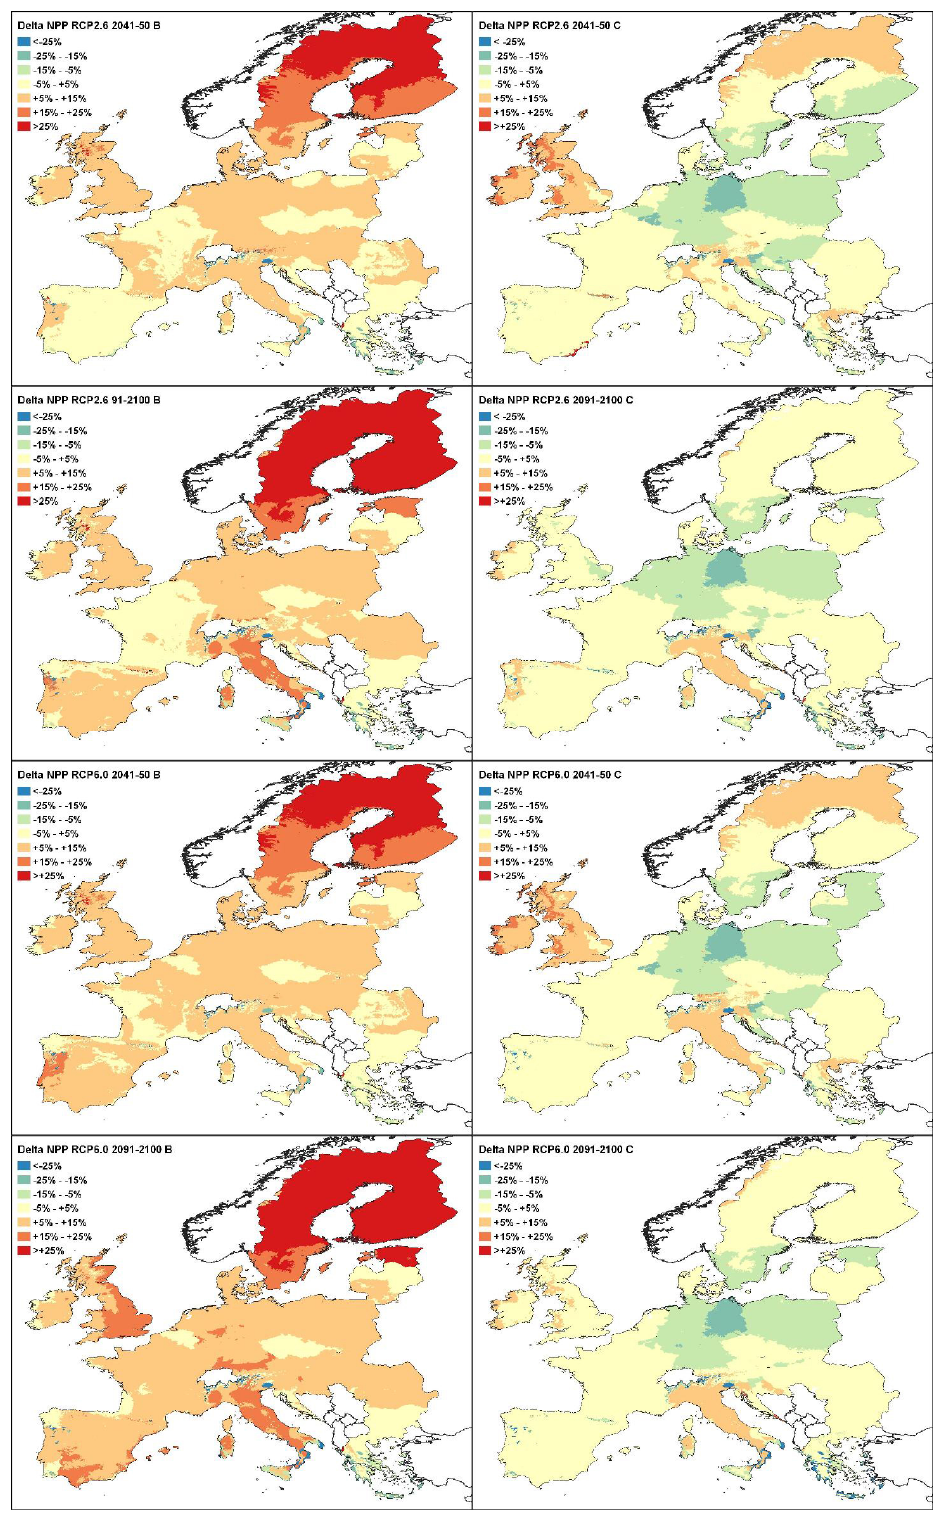
Figure 6. Relative variation in NPP due to climate change for broadleaved species (B, on the left side) and conifers (C, on the right side). The relative variation is estimated, for each country and CLU, as the average percentage difference between the NPP of the RS and the average NPP estimated from the four climatic models within the periods 2041–2050 and 2091–2100. The upper four panels refer to RCP2.6, and the lower four panels refer to